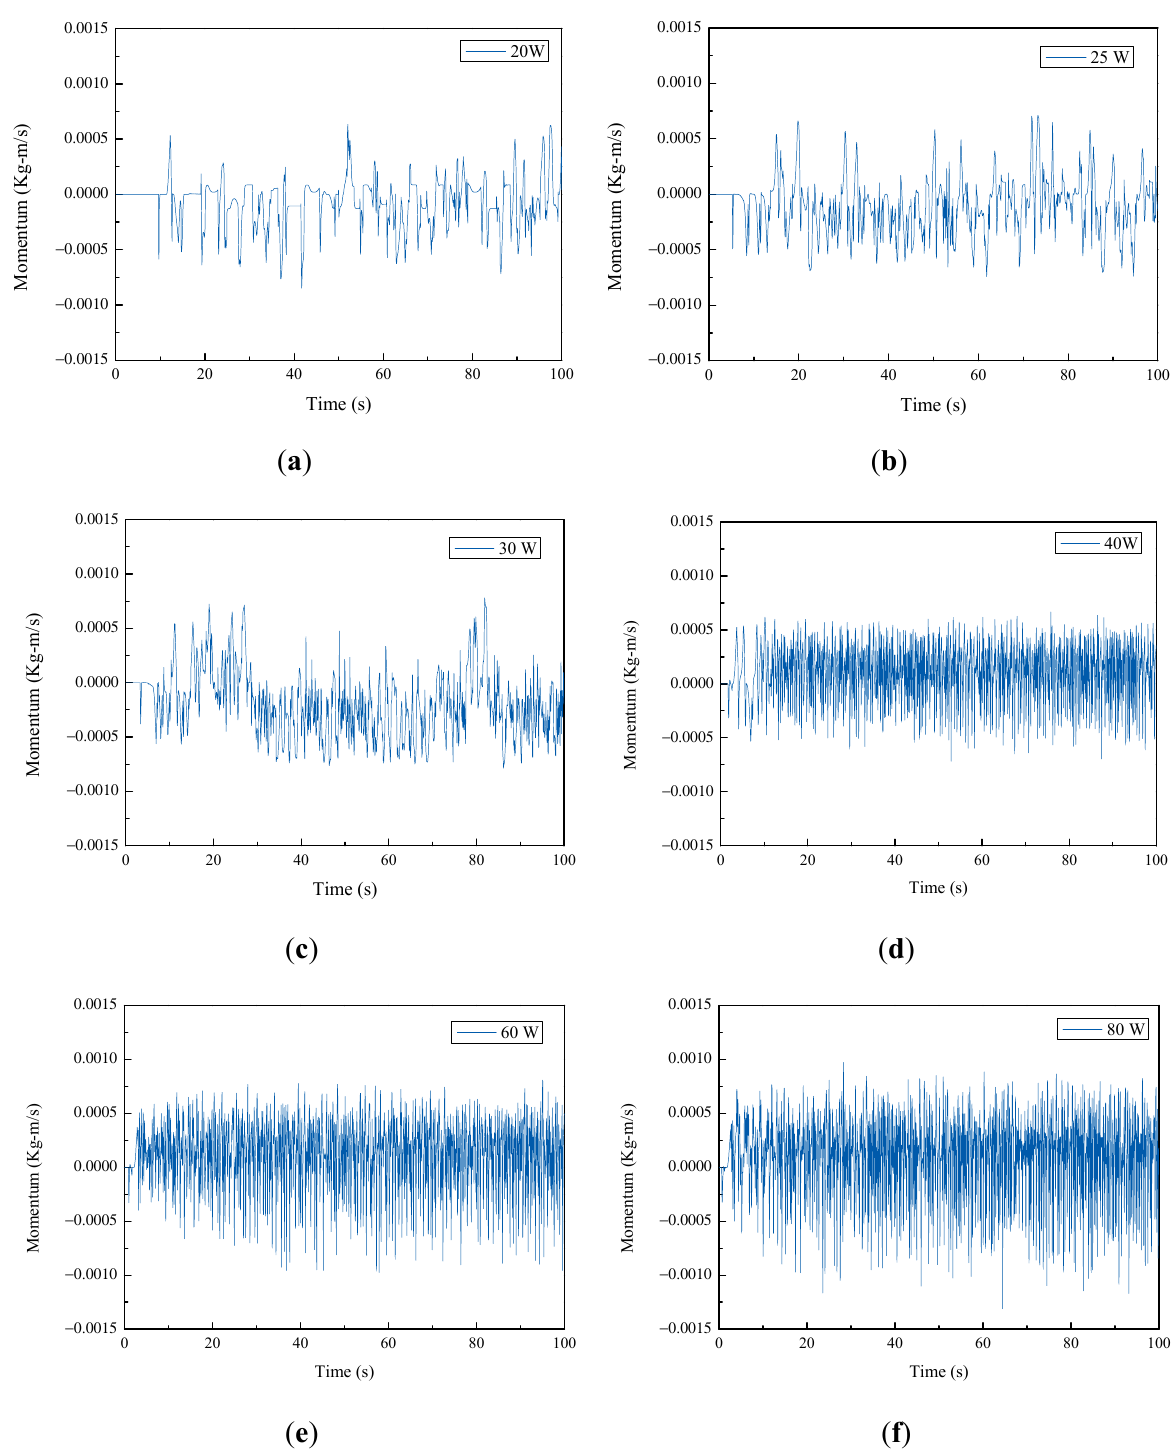
Figure 7. The momentum of the liquid slug inside the PHP with the adiabatic section of 180 mm at the heat input of ( a ) 20 W, ( b ) 25 W, ( c ) 30 W, ( d ) 40 W, ( e ) 60 W, and ( f ) 80 W.